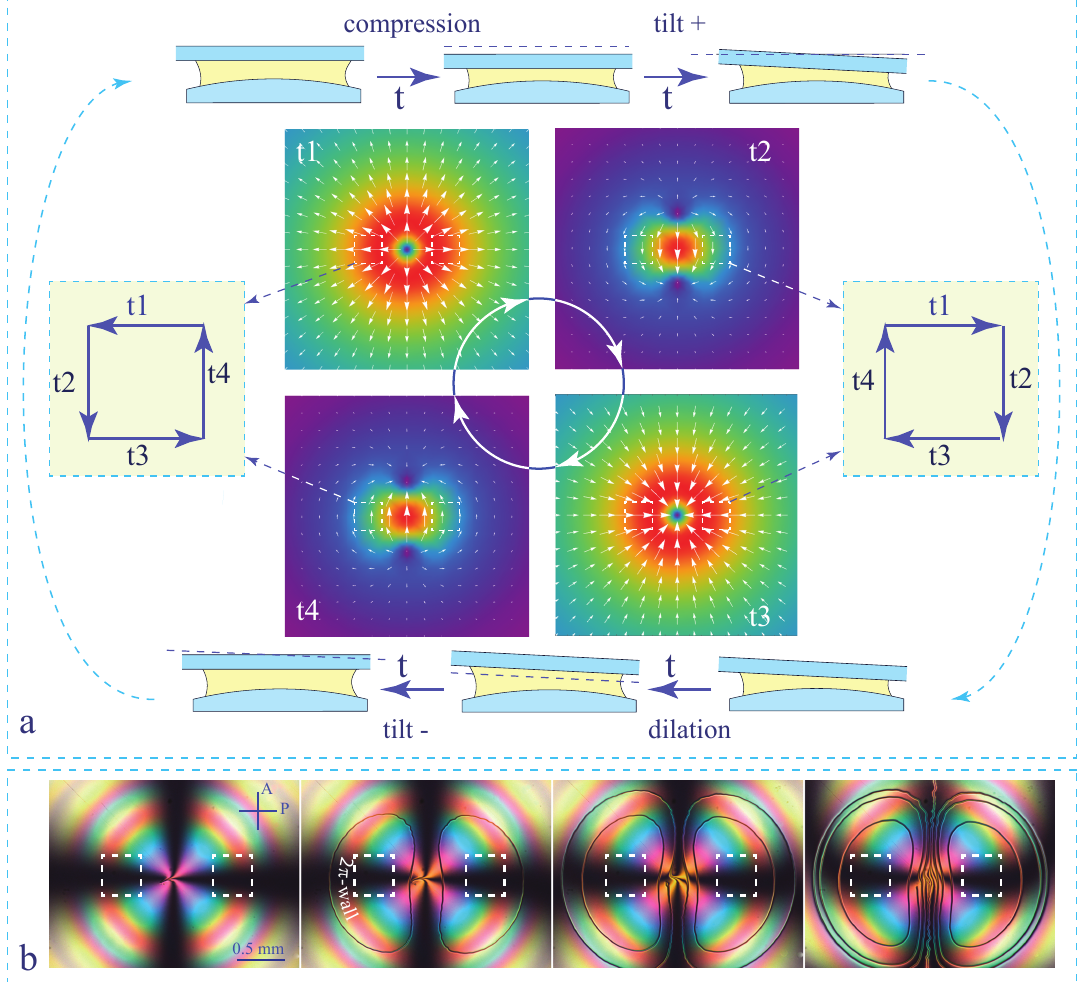
Figure 13. Winding of the dowser field by a sequence of radial and dipolar flows. ( a ) One sequence of radial and dipolar flows appropriate for the winding process. ( b ) Generation of three 2 π -walls loops by three successive sequences of